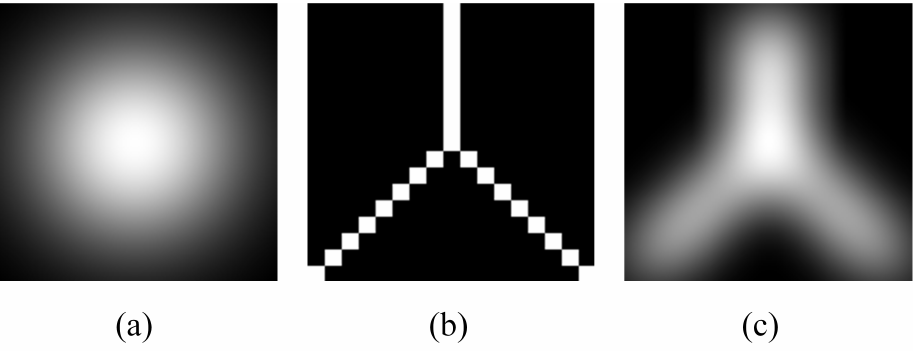
Figure 11. Optimizing Gaussian functions using topography. ( a ) Gaussian function. ( b ) Mask of mountain line. ( c ) Improved Gaussian function. Branch point extraction